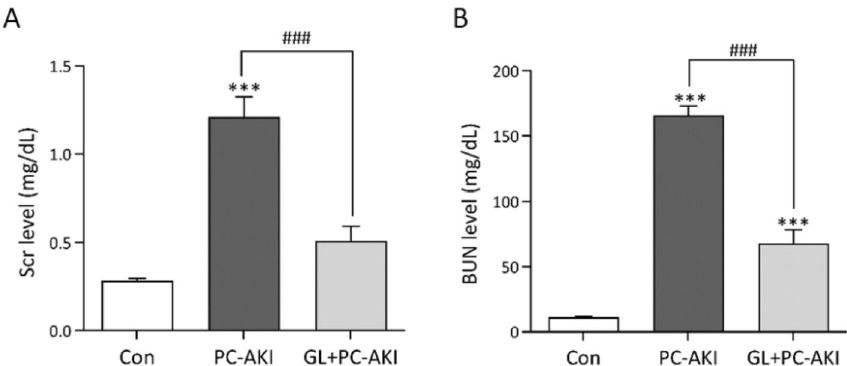
Figure 6. Effect of glycyrrhizin on renal function. (A-B) Compared to the controls, SCr and BUN significantly increased in the PC-AKI group, whereas they decreased in the PC-AKI with glycyrrhizin group compared to the PC-AKI group. Results were expressed as means ± SEMs. N = 8 for each group. Statistical significance: *** P < 0.001, Con vs PC-AKI and Con vs GL + PC-AKI, ### P < 0.001, PC-AKI vs GL + PC-AKI. Abbreviation: PC-AKI, post-contrast acute kidney injury; GL, glycyrrhizin; Scr, serum creatinine; BUN, blood urea nitrogen.